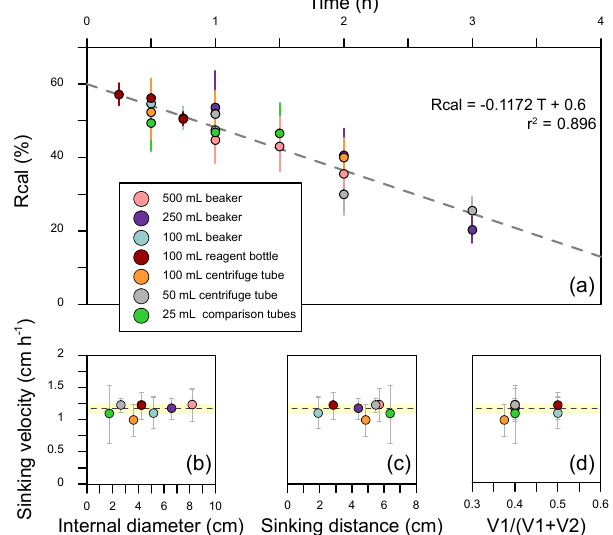
Figure 4. Sinking velocities of G. oceanica in the core KX-21- 2 measured in different vessels. (a) The calibrated separation ra- tios measured in different vessels. Error bars show 95% confidence level of calibrated separation ratio. (b–d) The relationship between sinking velocity and different vessel shape parameters. Error bars represent 95% confidence level of sinking velocity in each vessel, and the shaded area represents the 95% confidence level of sinking velocity considering all data